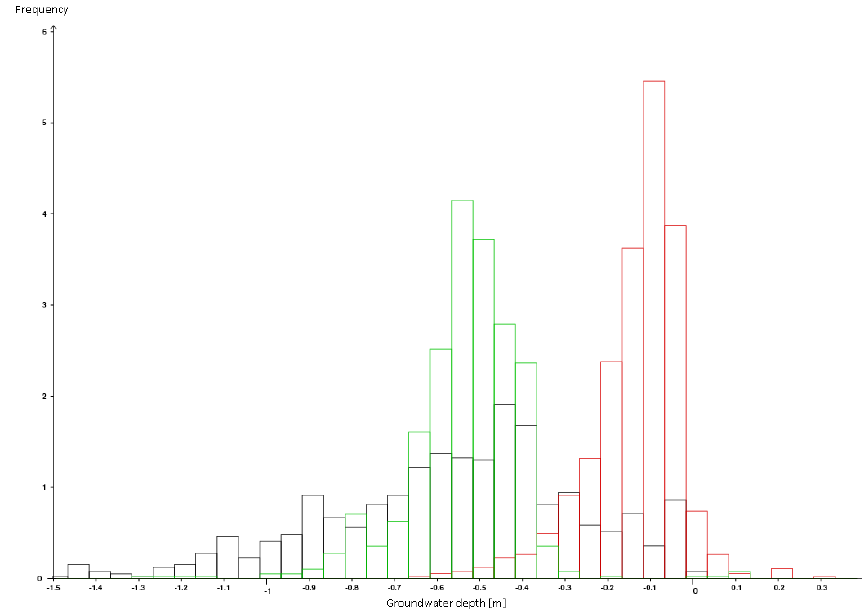
Figure 4. Histograms (in black, green and red) of groundwater levels at three different locations in the Groset catchment (6.33km 2 ) located in southern